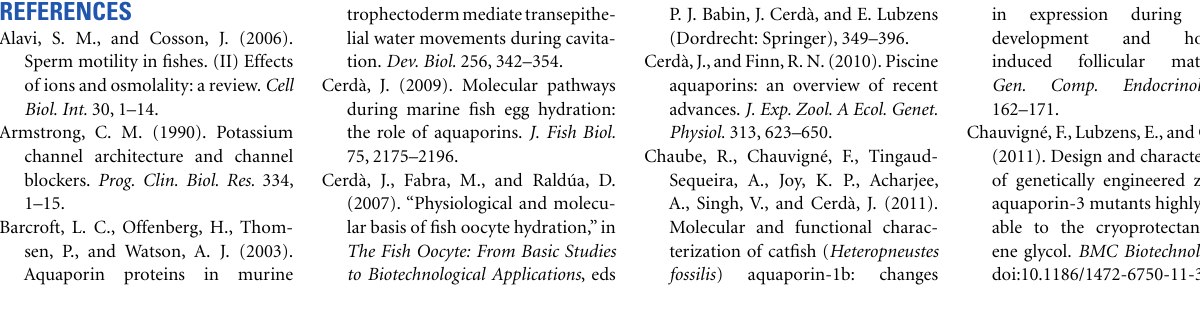
FIGURE 1 | Expression of aquaporins during teleost embryonic development. (A) Standart RT-PCR analyses of aquaporin transcriptional expression in zebrafish embryos reveals that aqp 3 a , - 7, and -10 b transcripts are detectable throughout development, whereas aqp 3 b and aqp 10 a expression is only detected during gastrulation and onward, and at the onset of organogenesis, respectively. (B–E) Whole-mount immulocalization of